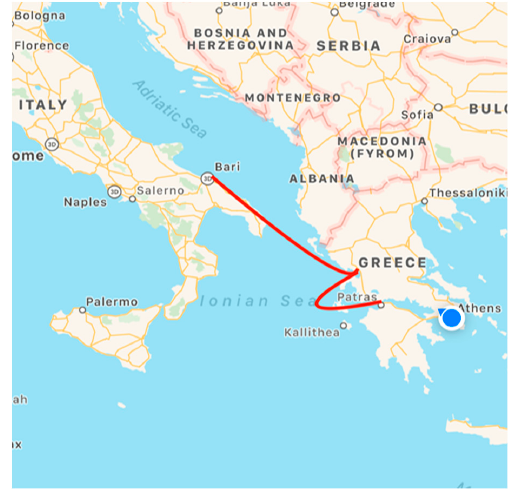
Figure 1. Route under study.